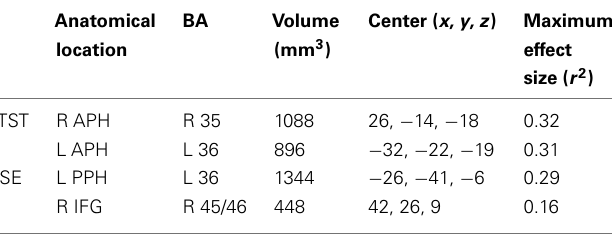
Table 5 | Brain regions showing a significant group × prior sleep interaction.